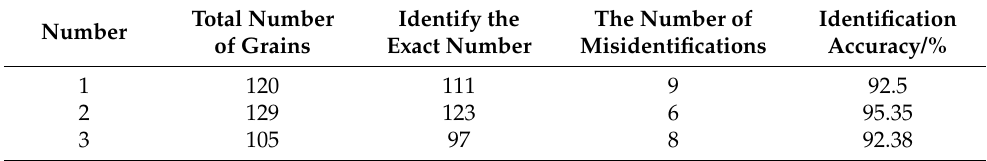
Table 6. Image recognition results of harvested corn kernels.